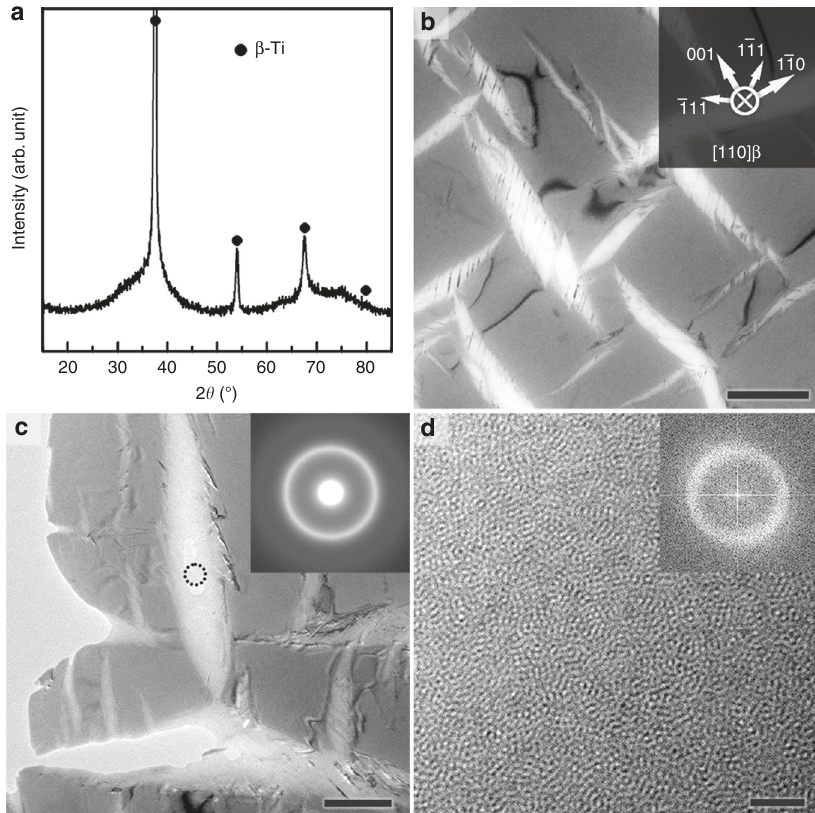
Fig. 1 Microstructure of the as-cast Ti 59.1 Zr 37 Cu 2.3 Fe 1.6 ingot. a Next to β -Ti re fl ections, a broad diffraction hump from an amorphous phase is found in the X-ray diffraction pattern. b Bright- fi eld TEM micrograph revealing lenticular bright regions with their long axes preferentially oriented along < 110 > β and < 001 > β . The lenses are embedded in a β -Ti matrix and are usually sheared multiple times along the < 111 > β directions. c Bright- fi eld TEM micrograph at a higher magni fi cation and a SAED pattern (as inset) from the centre of the lenticular region (see circle). The halo corroborates the presence of an amorphous phase. d HRTEM image from the region marked in c with the corresponding FFT image as inset. Both clearly imply that the lenticular regions are mainly amorphous. The scale bars are 1 μ m in b , 500 nm in c , and 2 nm in